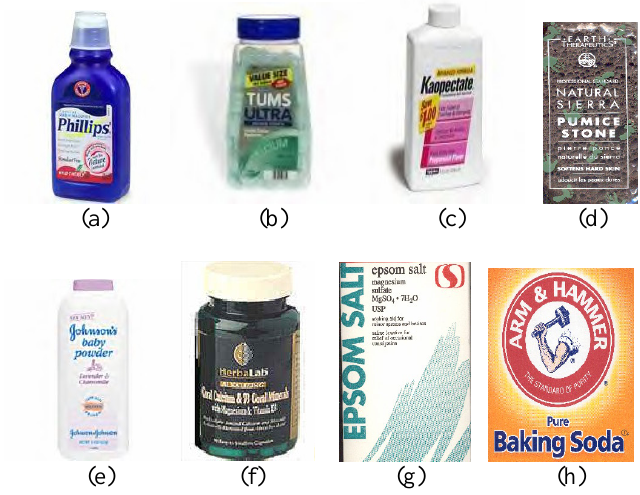
Figure 3: Minerals in everyday use. (a) Milk of magnesia, (b) Tums antacid, (c) Kaopectate, (d) natural pumice stone, (e) baby powder, (f) calcium supplement, (g) epsom salt, and (h) baking soda.